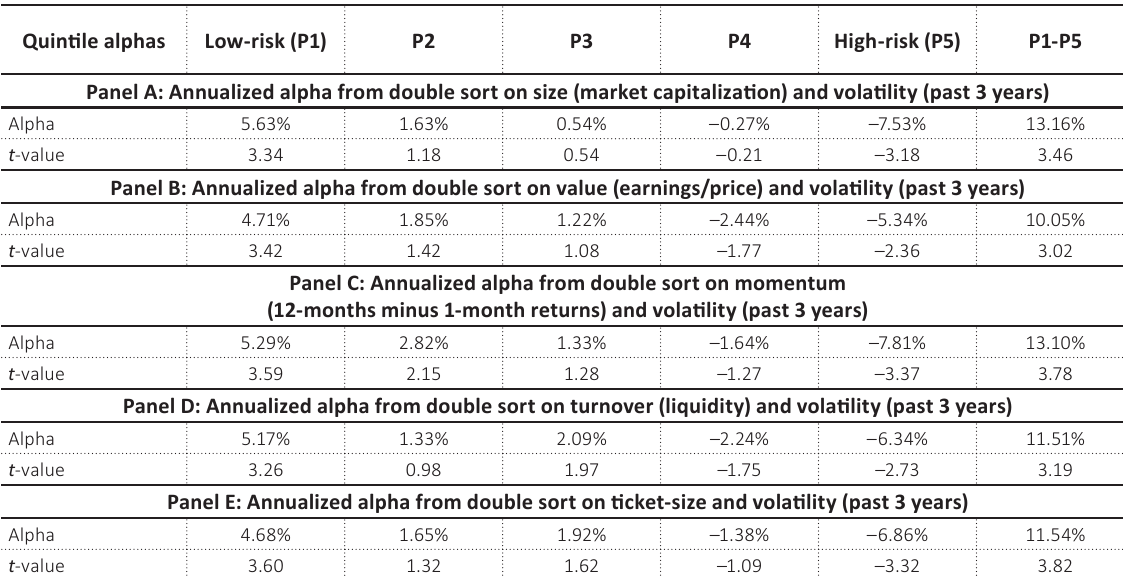
Quintile alphas Low-risk (P1)